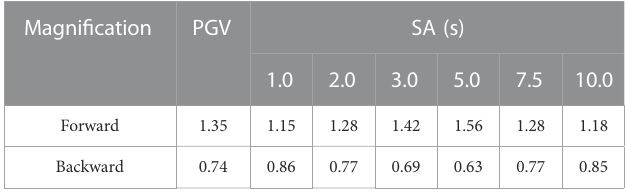
TABLE 4 The ampli fi cation and de-ampli fi cation coef fi cients of the directivity effect for various IMs.